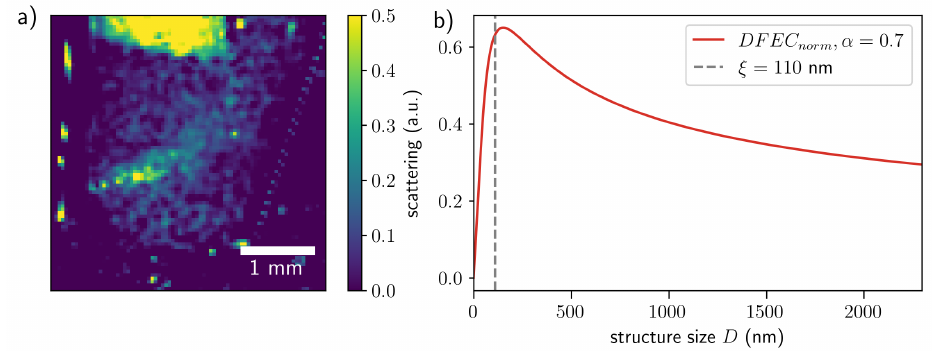
Figure 5. ( a ) Scattering contrast image at t = 320 s (sum over the two orthogonal directions); ( b ) the dark-field extinction coefficient (DFEC) calculated using Equation (2) for the autocorrelation function according to the simplest general model (Equation (3)) versus scattering structure size. The roughness exponent α was set to 0.7 as obtained for densely packed structures